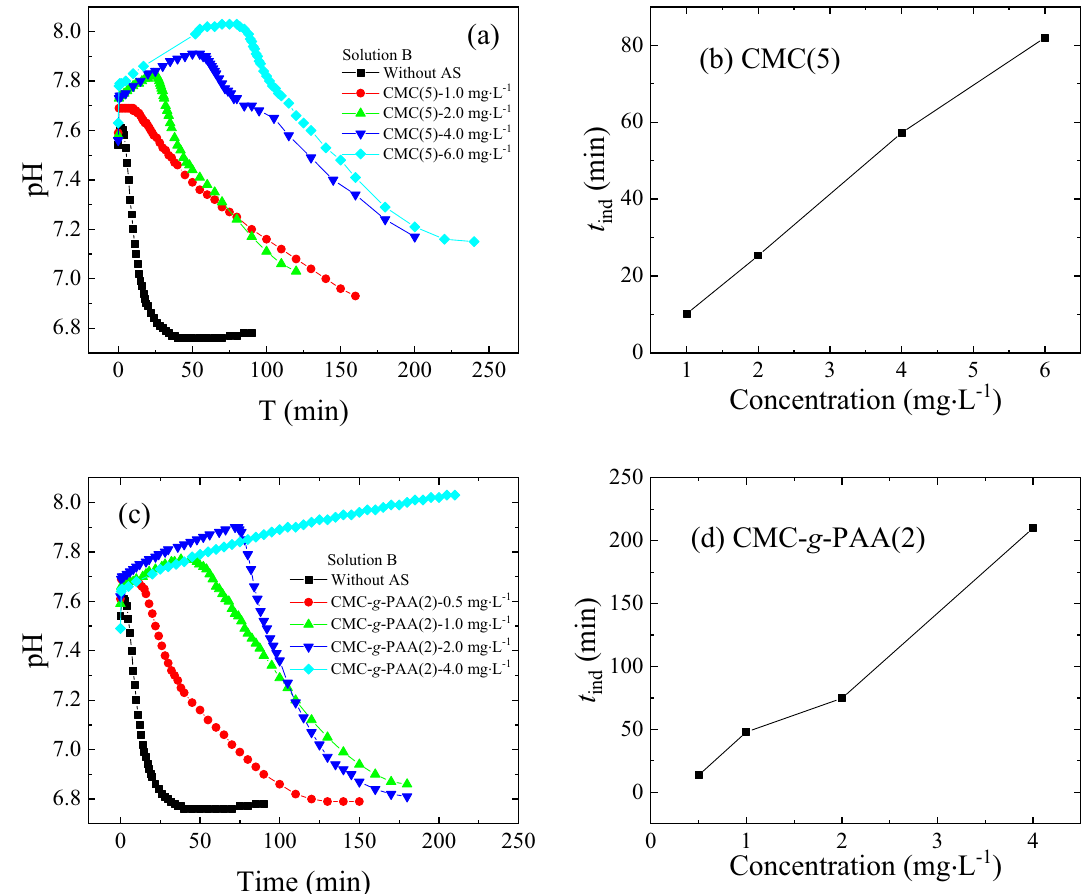
Figure 7. pH changes in the CaCO 3 crystal growth process using Solution B in the absence of antiscalants and in the presence of different concentrations of ( a ) CMC(5) and ( c ) CMC- g -PAA(2). According to ( a ) and ( c ), the relations between t ind and the different concentrations of various antiscalants, i.e., ( b ) CMC(5) and ( d ) CMC- g - PAA(2), were